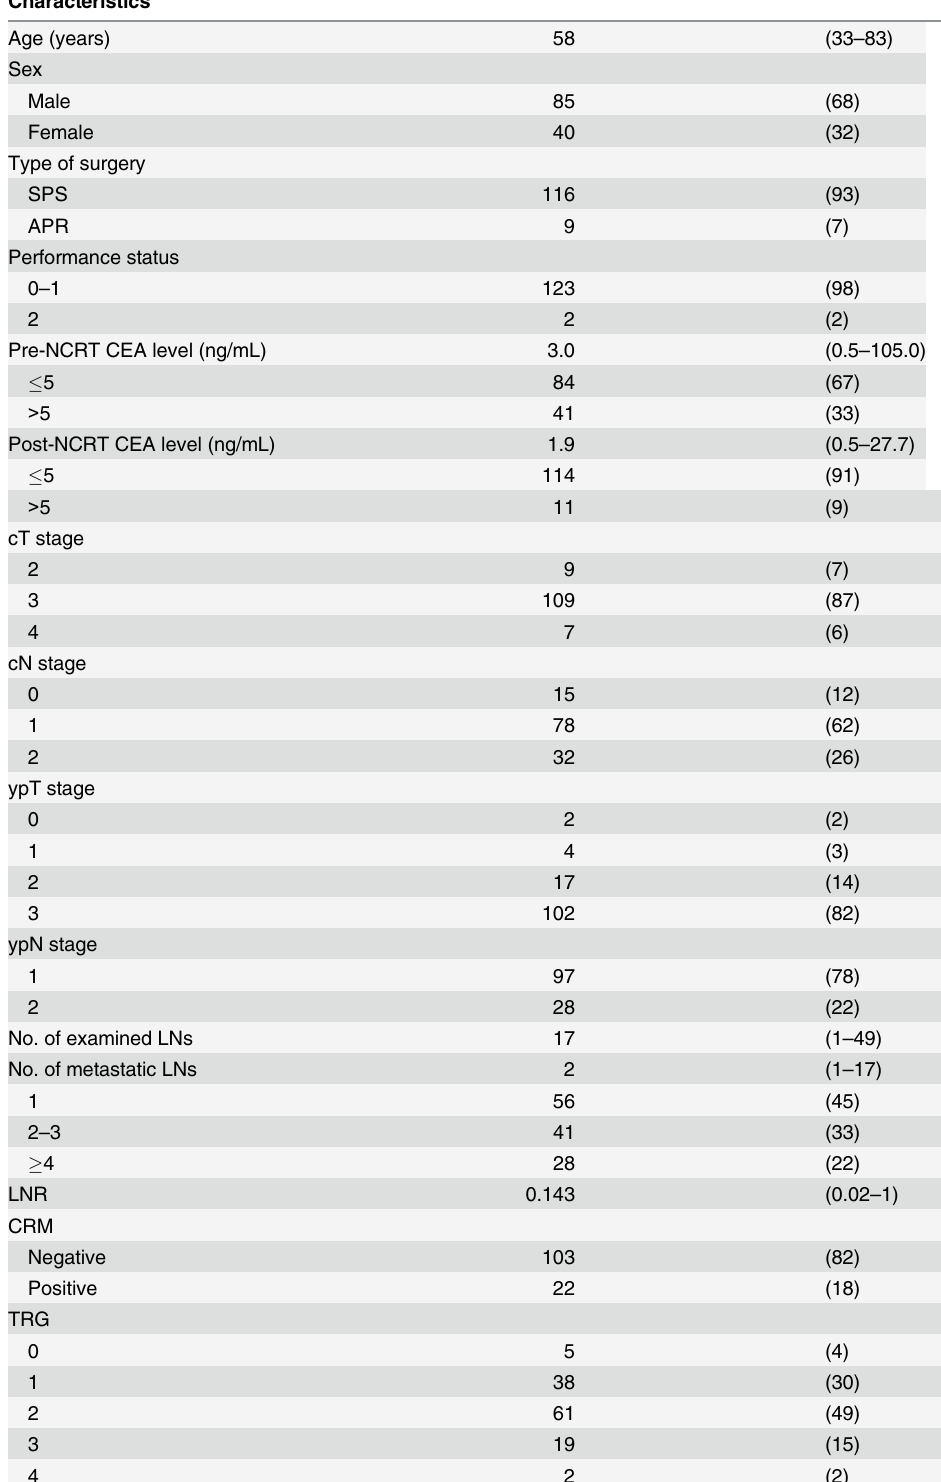
Table 1. Patient and tumor characteristics (n =